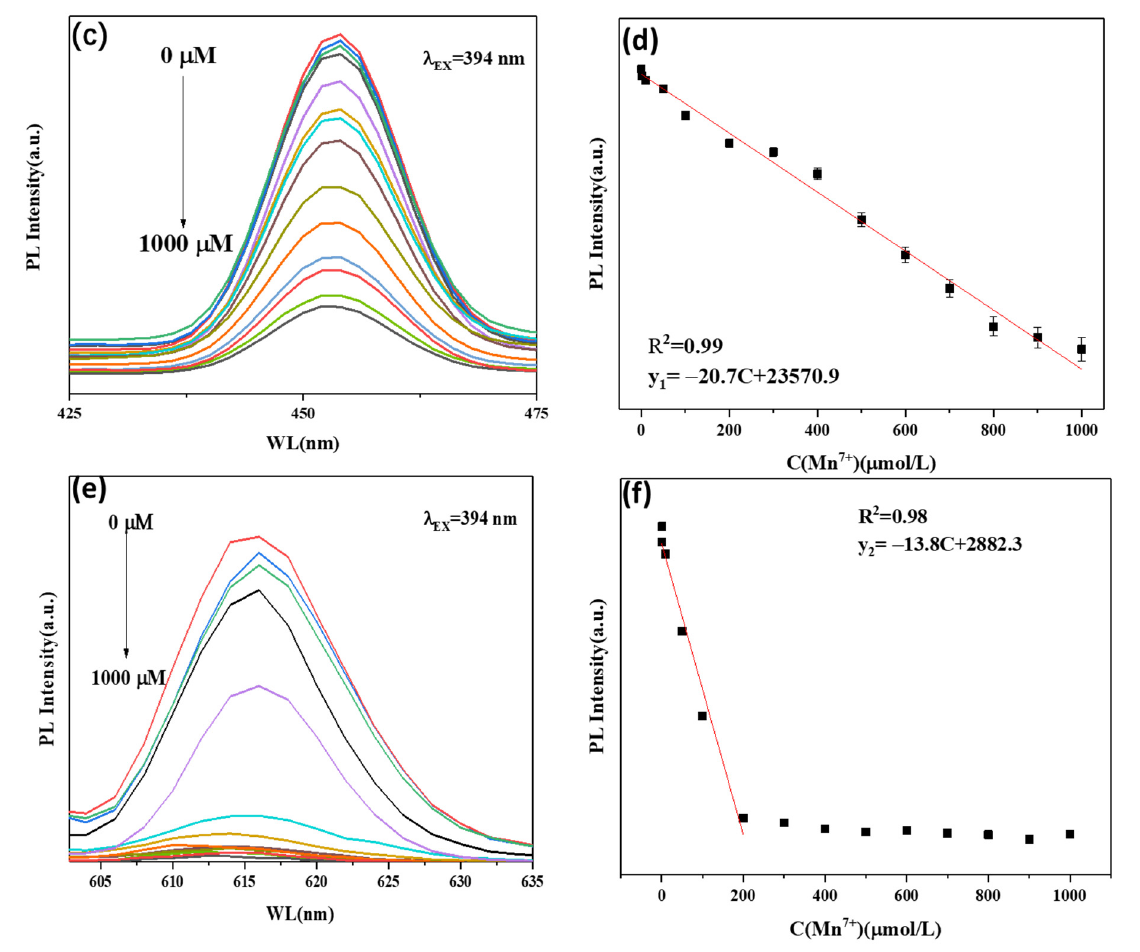
Figure 10. ( a ) Fluorescence spectra of TiO 2 -ETP with metal ions, ( b ) fluorescence intensity ratio (I/I 0 ) of the TiO 2 -ETP in an aqueous solution containing no metal ions and a solution containing a single metal ion, ( c , e ) fluorescence intensity versus cation concentration for the addition of the Mn 7+ ions, ( d , f ) the linear plot of ∆ F/F 0 against the concentration of Mn 7+ .